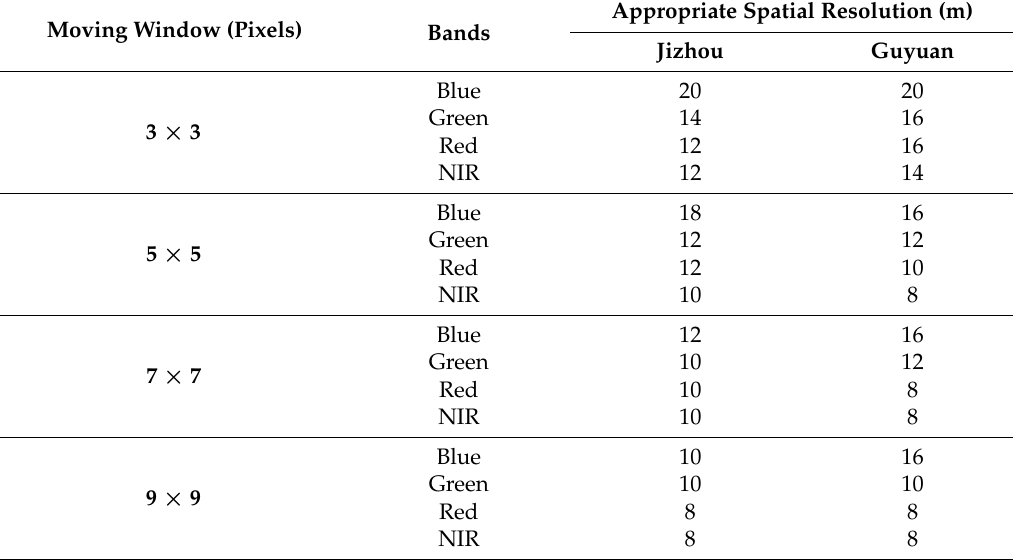
Table 3. The appropriate spatial scales obtained from the average local variance (ALV) in Jizhou and Guyuan.